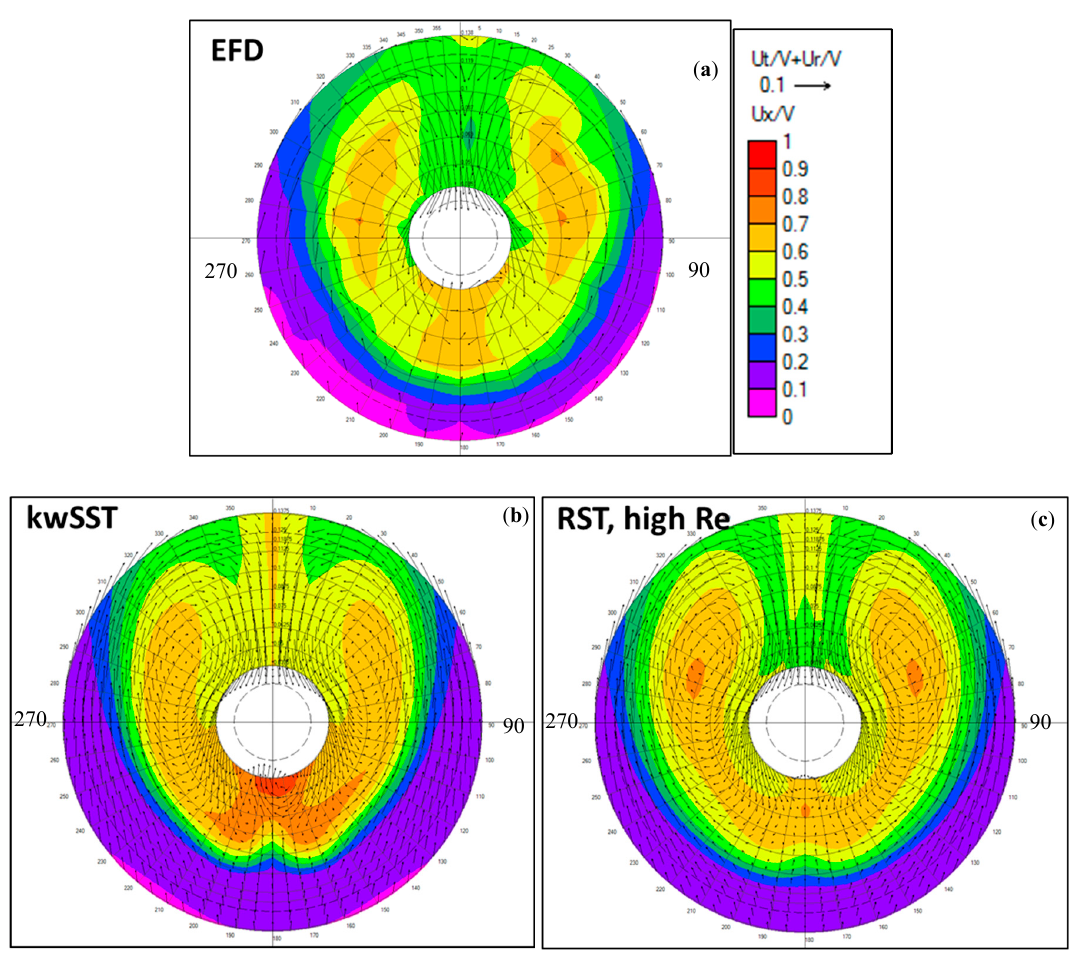
Figure 3. Measured and computed nominal wake field on the propeller plane. (Model scale, Vs = 14 kn, without ESD). ( a ) measured results. ( b ) CFD results using kwSST. ( c ) CFD results using RST, high Re.